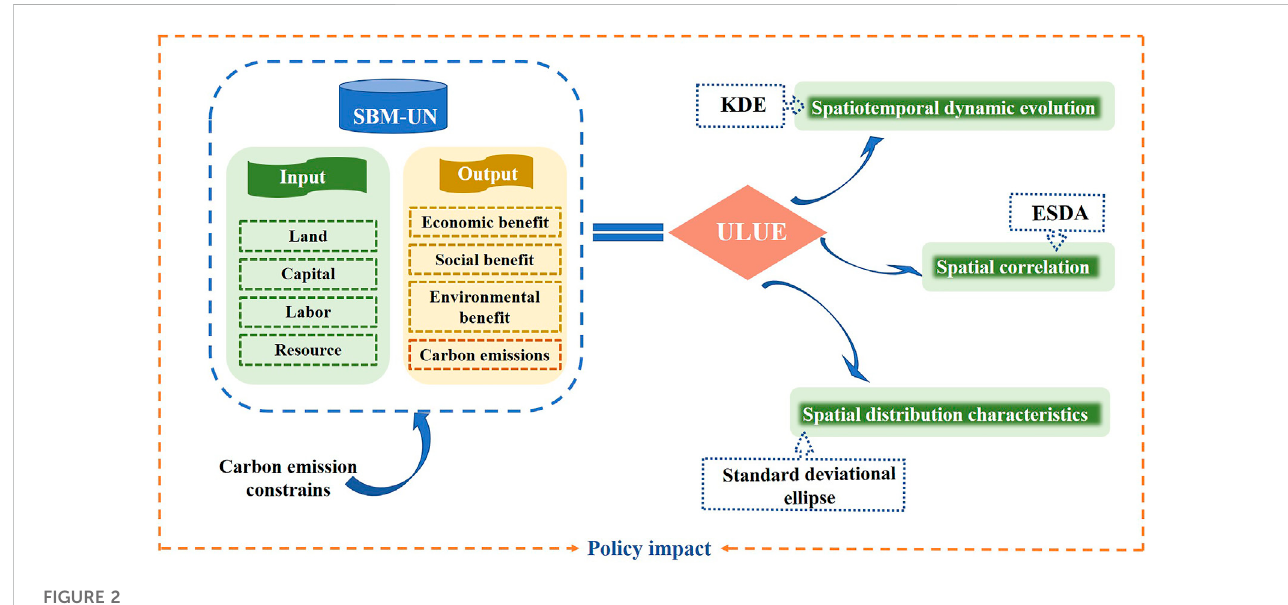
② Social bene fi ts. The social bene fi ts of ULUE are mainly re fl ected in the improvement of residents ’ social level and quality of life (Li et al., 2014), and the disposable income of urban residents is used to represent the social bene fi ts of urban land use output according to people ’ s good wishes. ③ Environmental bene fi ts.